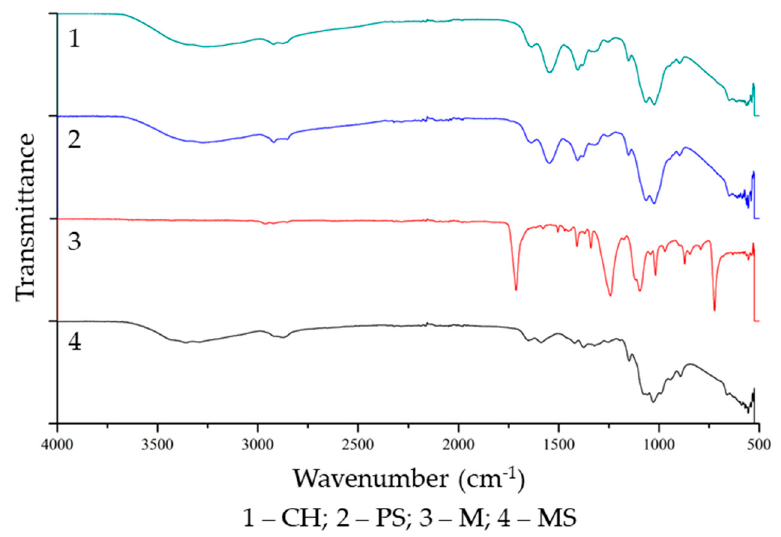
Figure 3. FTIR spectra of the chitosan (CH), the support (PS), and the non-supported (M) and supported (MS) membranes. supported (MS) membranes.